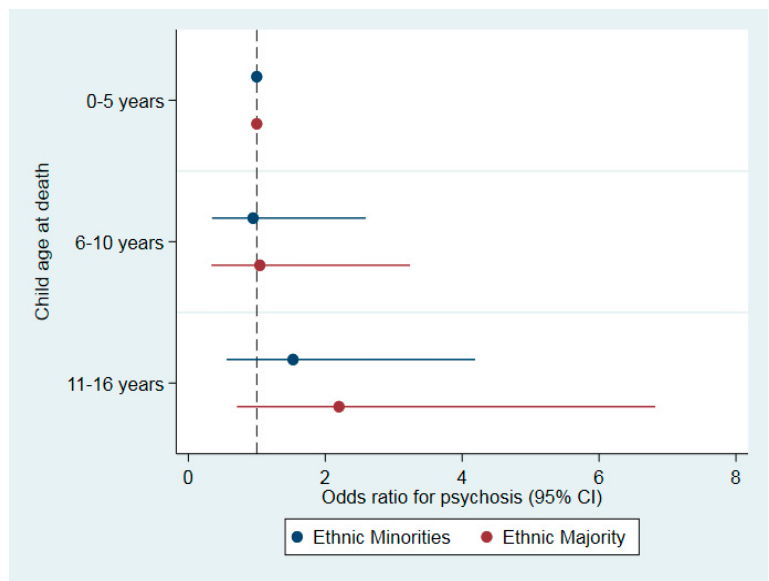
Figure 2. Association between child’s age at early parental death and odds of psychosis, stratified by ethnic group in the EU-GEI case-control